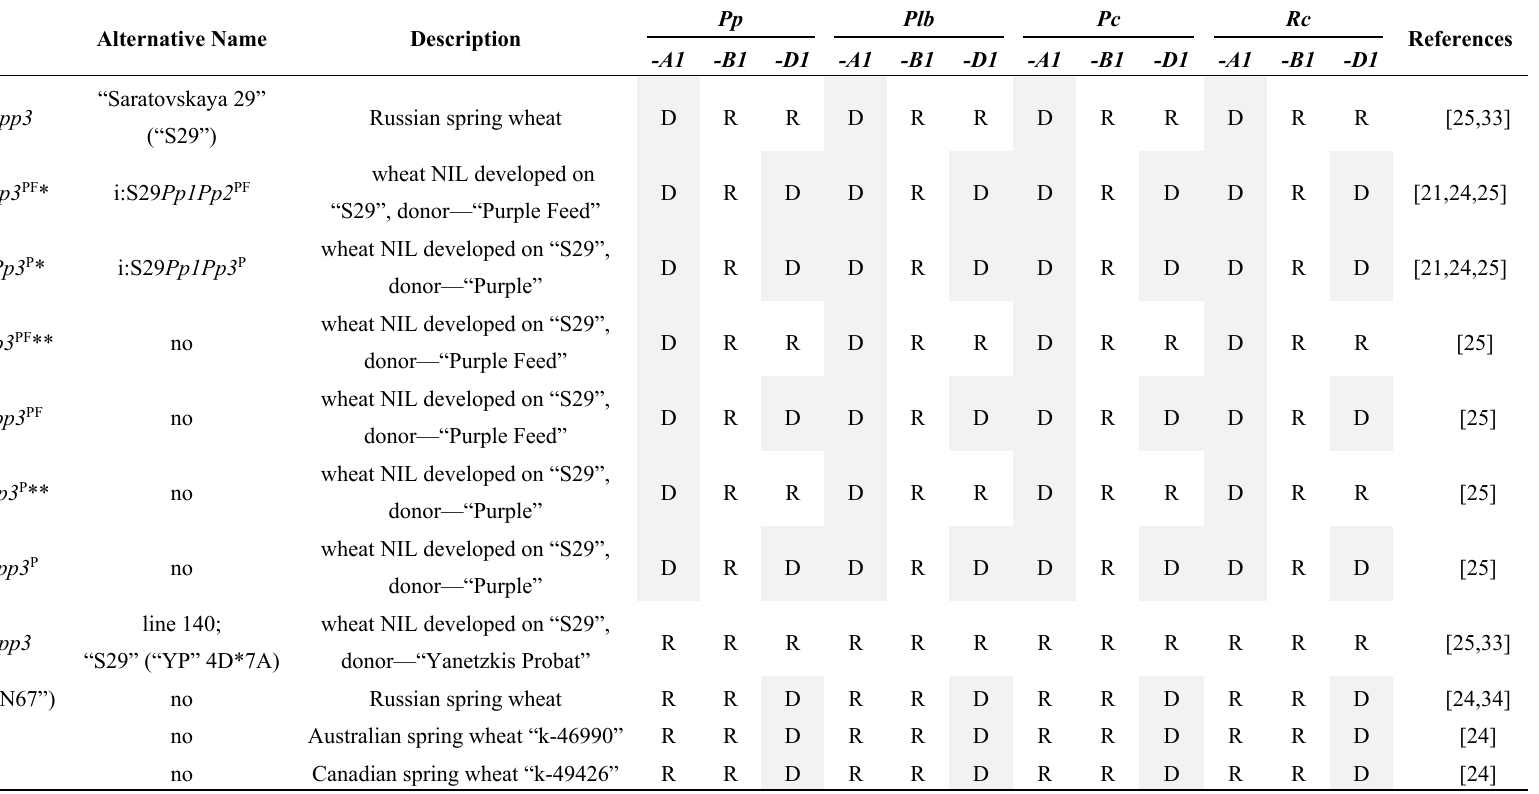
► names for NILs obtained on “Saratovskaya 29” with dominant alleles Pp-D1 and/or Pp3 inherited from cultivars “Purple” (P) or “Purple Feed” (PF); in these lines dominant allele of Pp-A1 is from “Saratovskaya 29”; ◄ name for NIL obtained on “Saratovskaya 29” with its own recessive alleles pp-D1 and pp3 and recessive pp-A1 inherited from “Yanetzkis